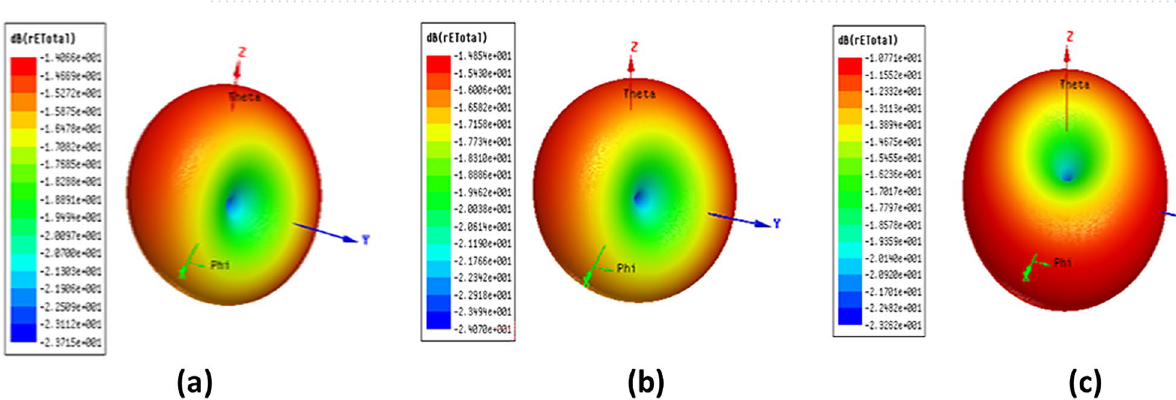
Figure 8. The Radiation pattern ( a ) E-plane at φ = 0 and ( b ) H-plane at φ = 90°.